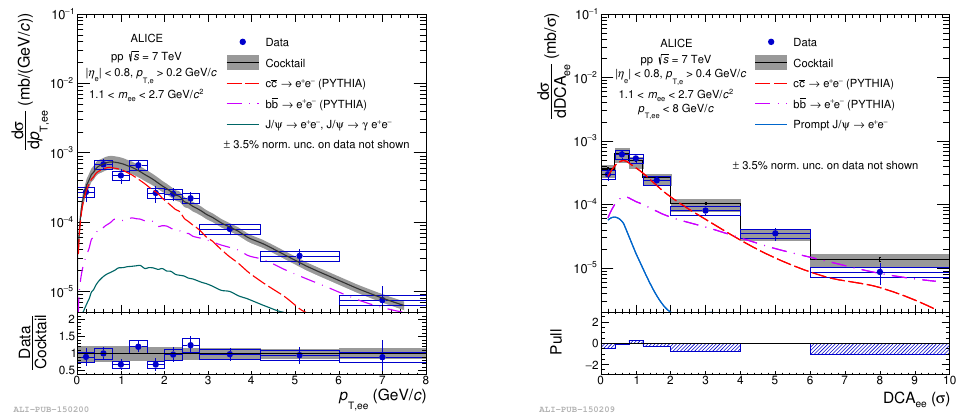
Figure 4. Dielectron cross section as a function of p T,ee ( left ) and DCA ee ( right ) in the IMR compared to a cocktail calculated with PYTHIA 6